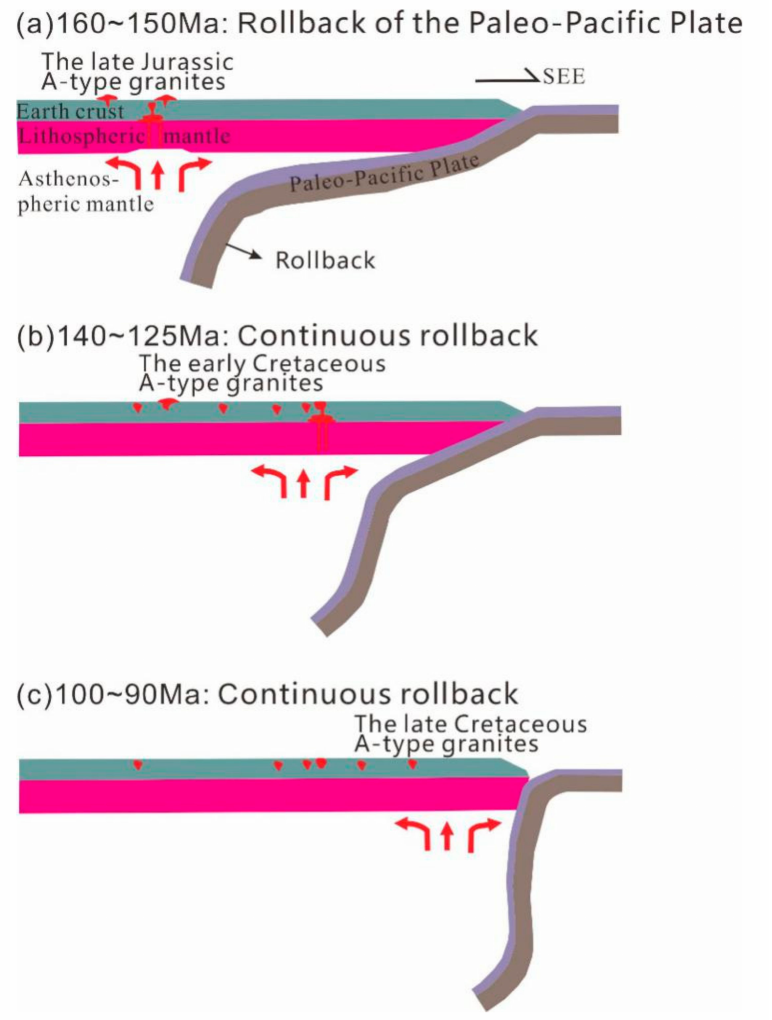
Figure 12. A geodynamic modal accounting for the genesis of the Yanshanian NE-trending A-type granite belts in South